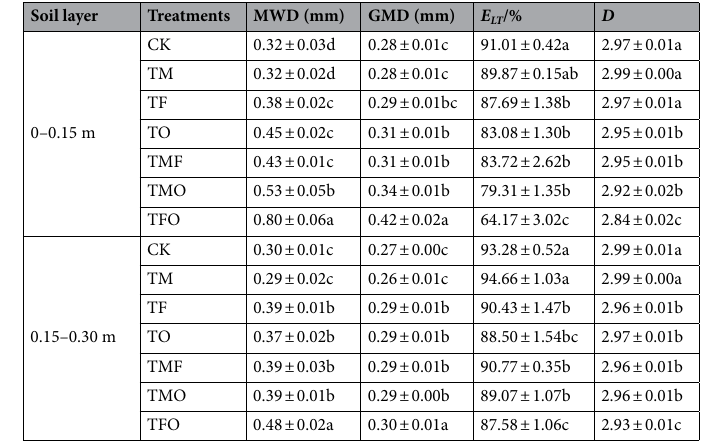
Table 1. Effects of the application of different improved materials on water-stable aggregate stability indexes. GMD, geometric mean diameter; MWD, mean weight diameter; E LT , unstable aggregate index; D , fractal dimension. Different lowercase letters represent significant differences among different improved material treatments in the same aggregate stability index.